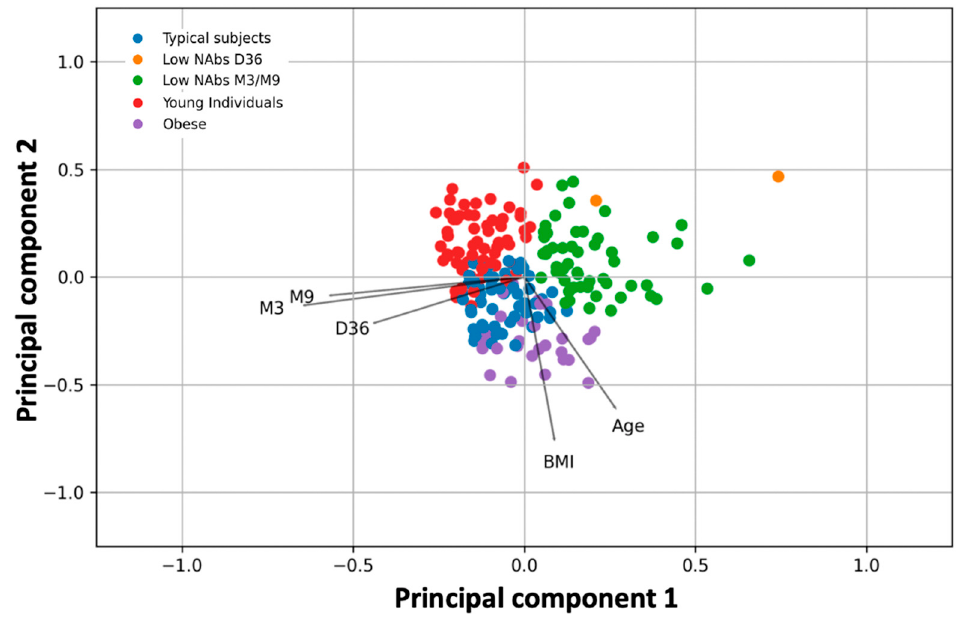
Figure 2. Principal component analysis of the features used in the study. The color of the dots is from the k-means cluster analysis, which divides the subjects into five groups, each with one distinguishing feature. The coordinates of the two-dimensional plot refer to the “scores” of the variables in the dimensionality-reduced space (two dimensions (principal components) are shown in the plot). Key : D36, neutralizing antibody levels two weeks after second vaccination; M3 neutralizing antibody levels three months after second vaccination; M9, neutralizing antibody levels nine months after second vaccination; BMI, body mass index.